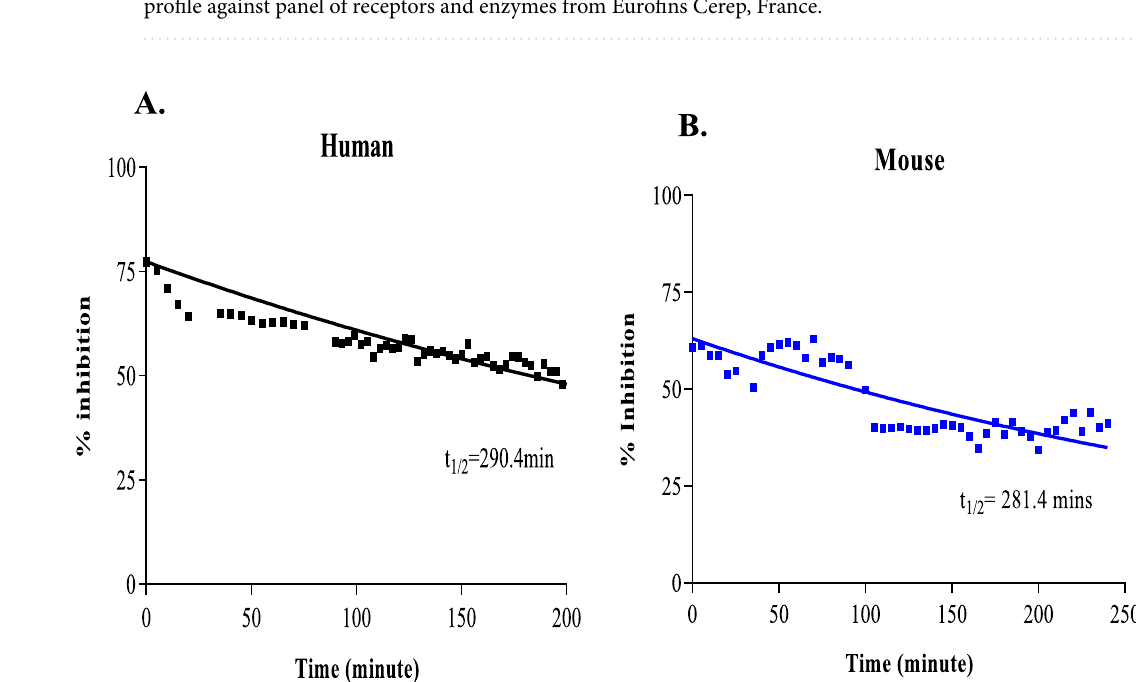
Figure 2. PCCR-1 strongly binds with RORγ across species. Binding affinity of PCCR-1 for human and mouse RORC/γ observed by jump dilution method. ( A ). Human binding affinity ( B ). Mouse binding affinity. The data representative of four separate experiments.